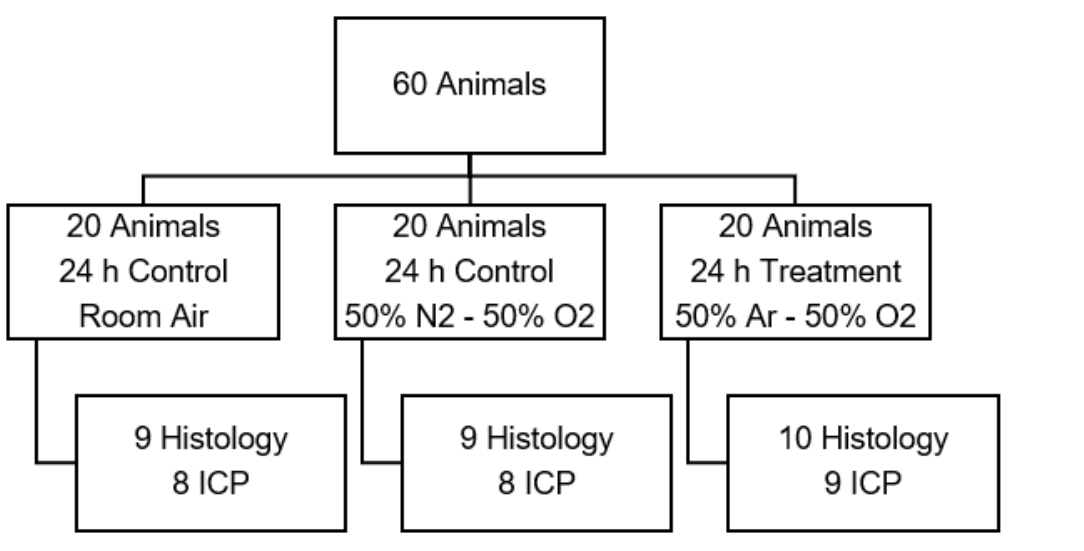
Figure 2. Animal distribution of test series B to examine the influence of argon mixture. (Ar: argon; O2: oxygen; ICP: intracranial pressure measurement).